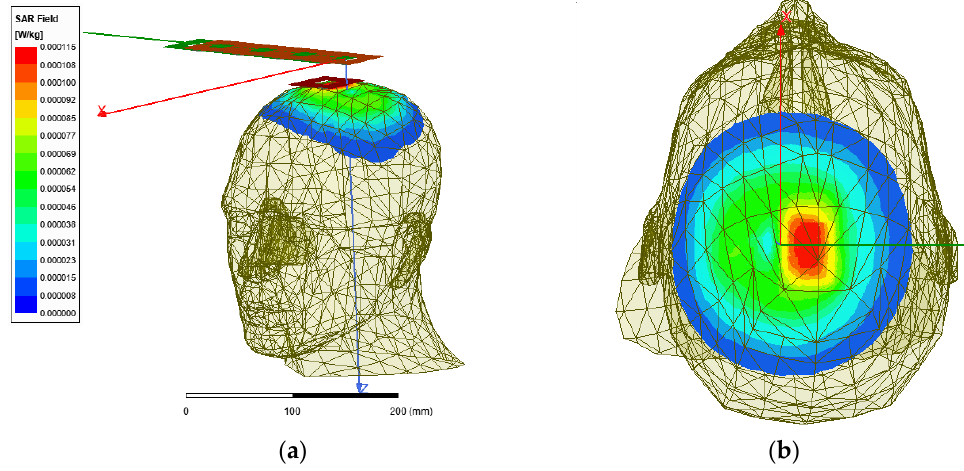
Figure 11. 3D SAR for human head at 13.56 MHz For internal coil excited by overlapped external coil array. ( a ) SAR side view. ( b ) SAR top view. Table 2. A comparison between the proposed system and similar studies based on the main specifica- tions of the